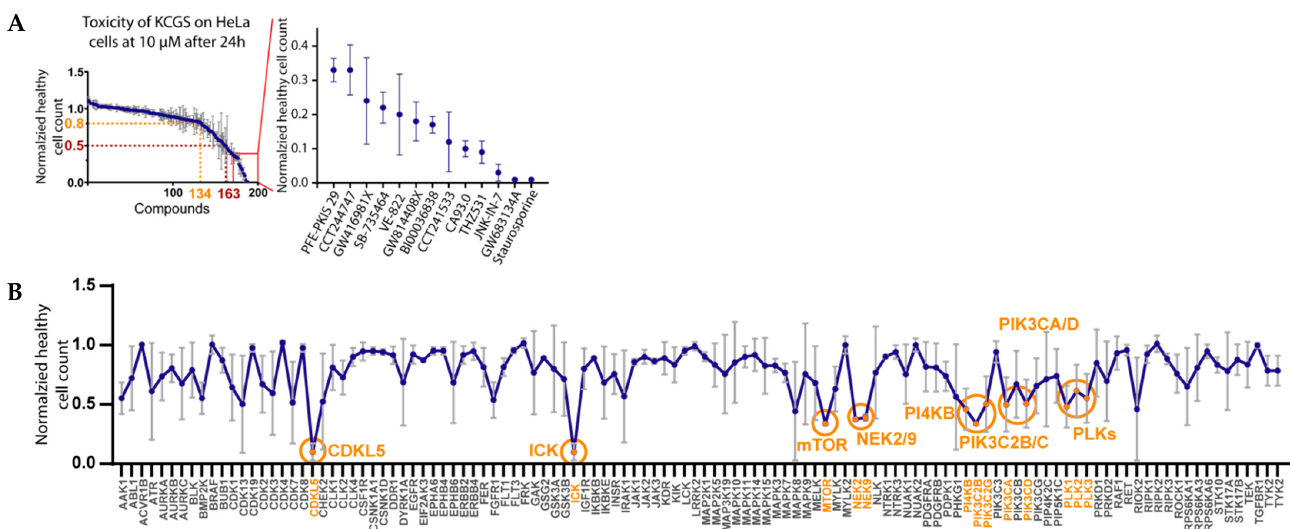
Figure 4. Cell toxicity assessment. ( A ) Effects of KCGS compounds at 10 µM on HeLa cells after 24 h. Measurements were made in triplicate with standard errors shown. Shown is the normalized healthy cell count with highlighted thresholds of 0.8 (80% healthy cells) and 0.5 (50% healthy cells). The panel on the right side displays the compounds with the greatest effect on healthy cell count in HeLa cells. ( B ) Averaged toxicity measured by normalized healthy cell count for every target covered by two or more chemotypes. Highlighted are target kinases that show a significantly lower healthy cell count than the DMSO control.